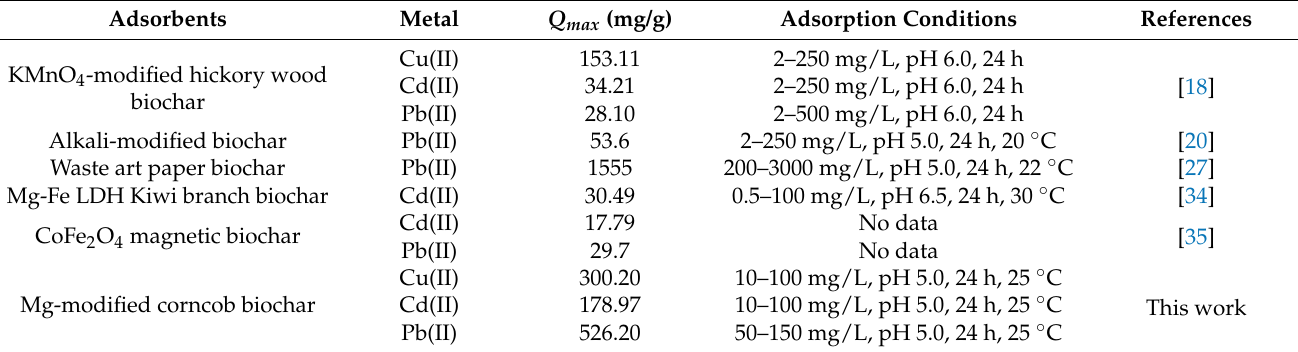
Table 4. Adsorption capacity of modified biochars for metal sorption from aqueous solutions.